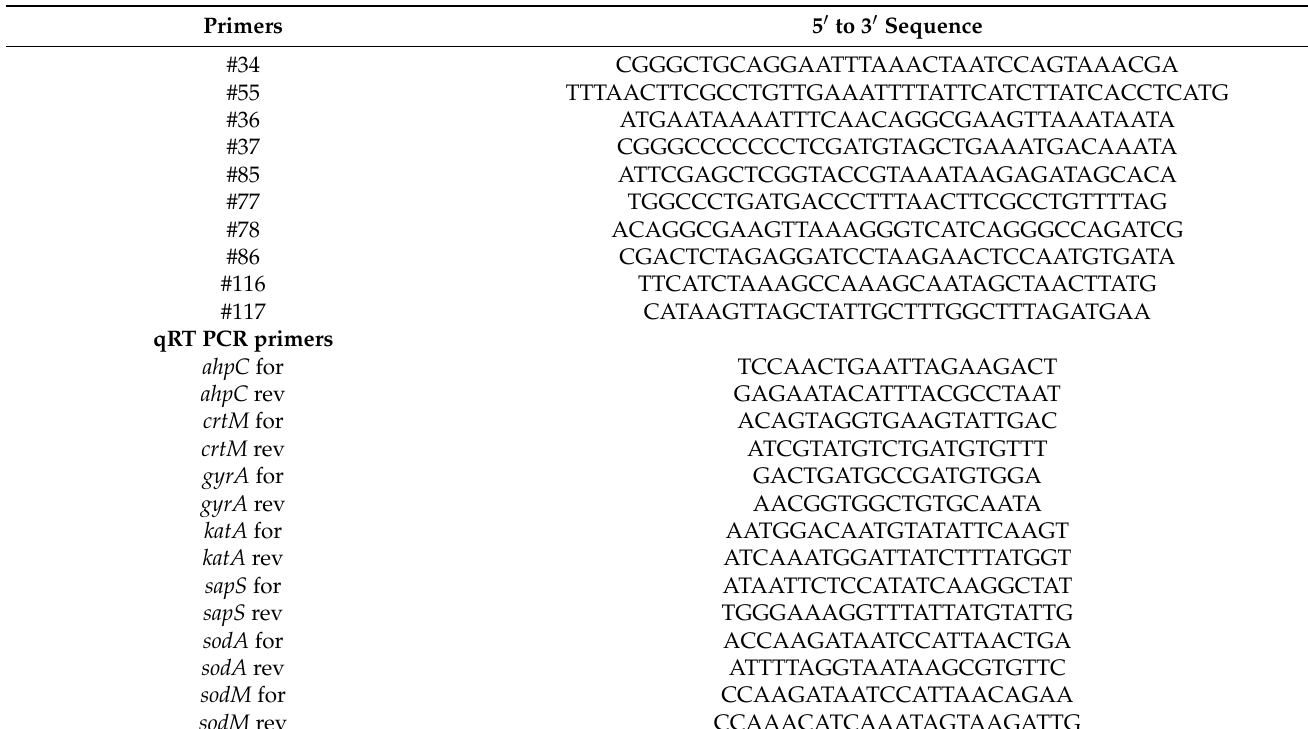
Table 2. Primers used in this